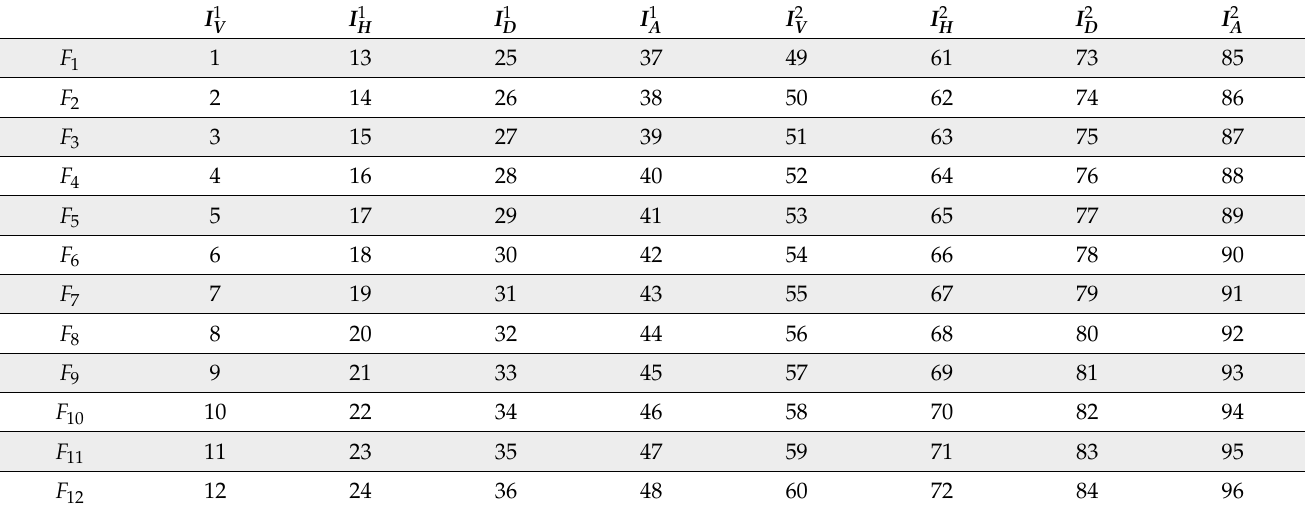
Table 3. Index labels of features extracted from image matrices.